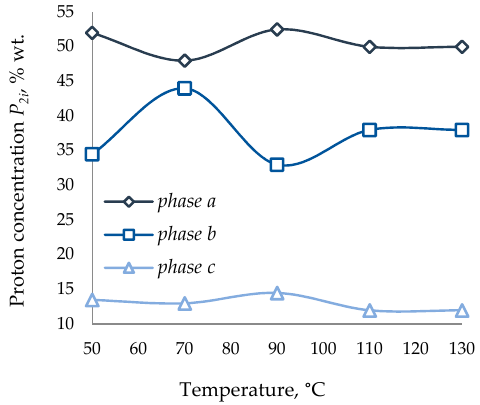
Figure 4. Proton concentration P 2 i of bitumen vs. temperature.